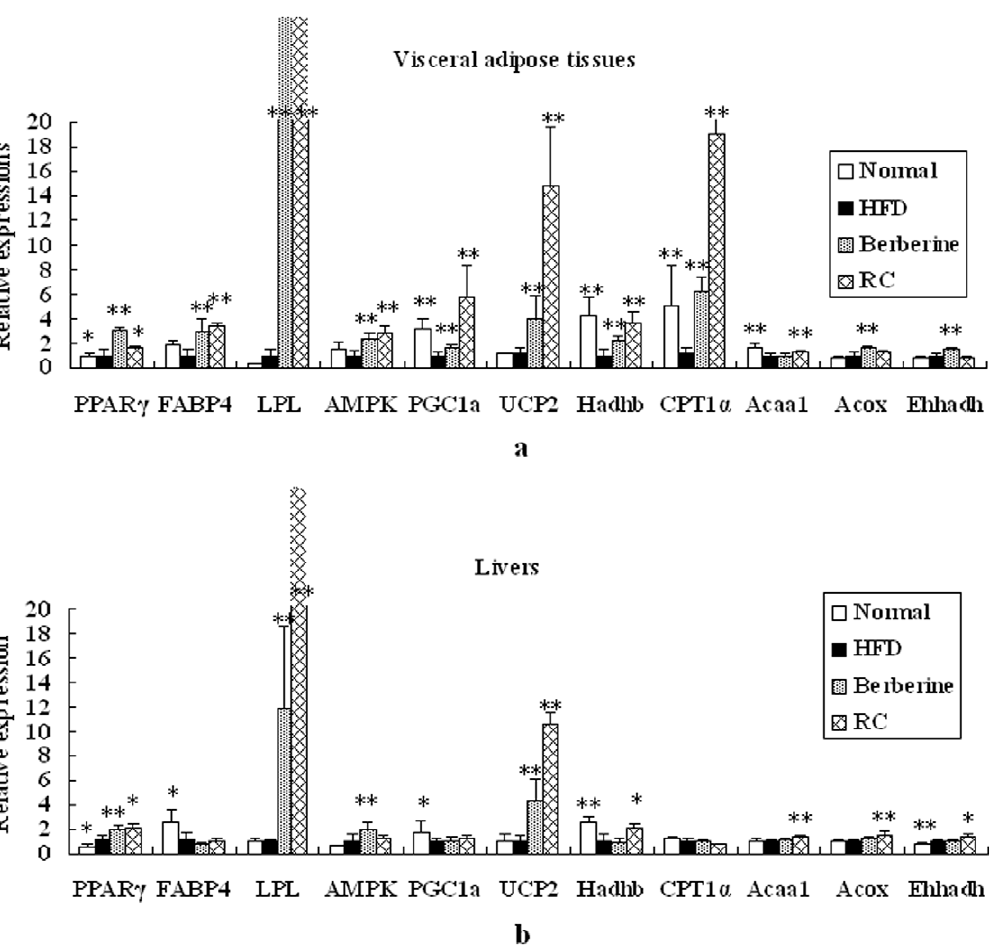
Figure 6. Effects of RC and berberine on gene expressions in visceral adipose tissues and livers. ‘‘Normal’’, normal chow diet-fed mice; ‘‘HFD’’, high-fat diet-fed control mice; ‘‘berberine’’, berberine-treated HFD mice; ‘‘RC’’, Rhizoma coptidis -treated HFD mice. Data were expressed as Mean 6 S.D. (n=6), * P , 0.05, ** P , 0.01 vs. HFD controls.